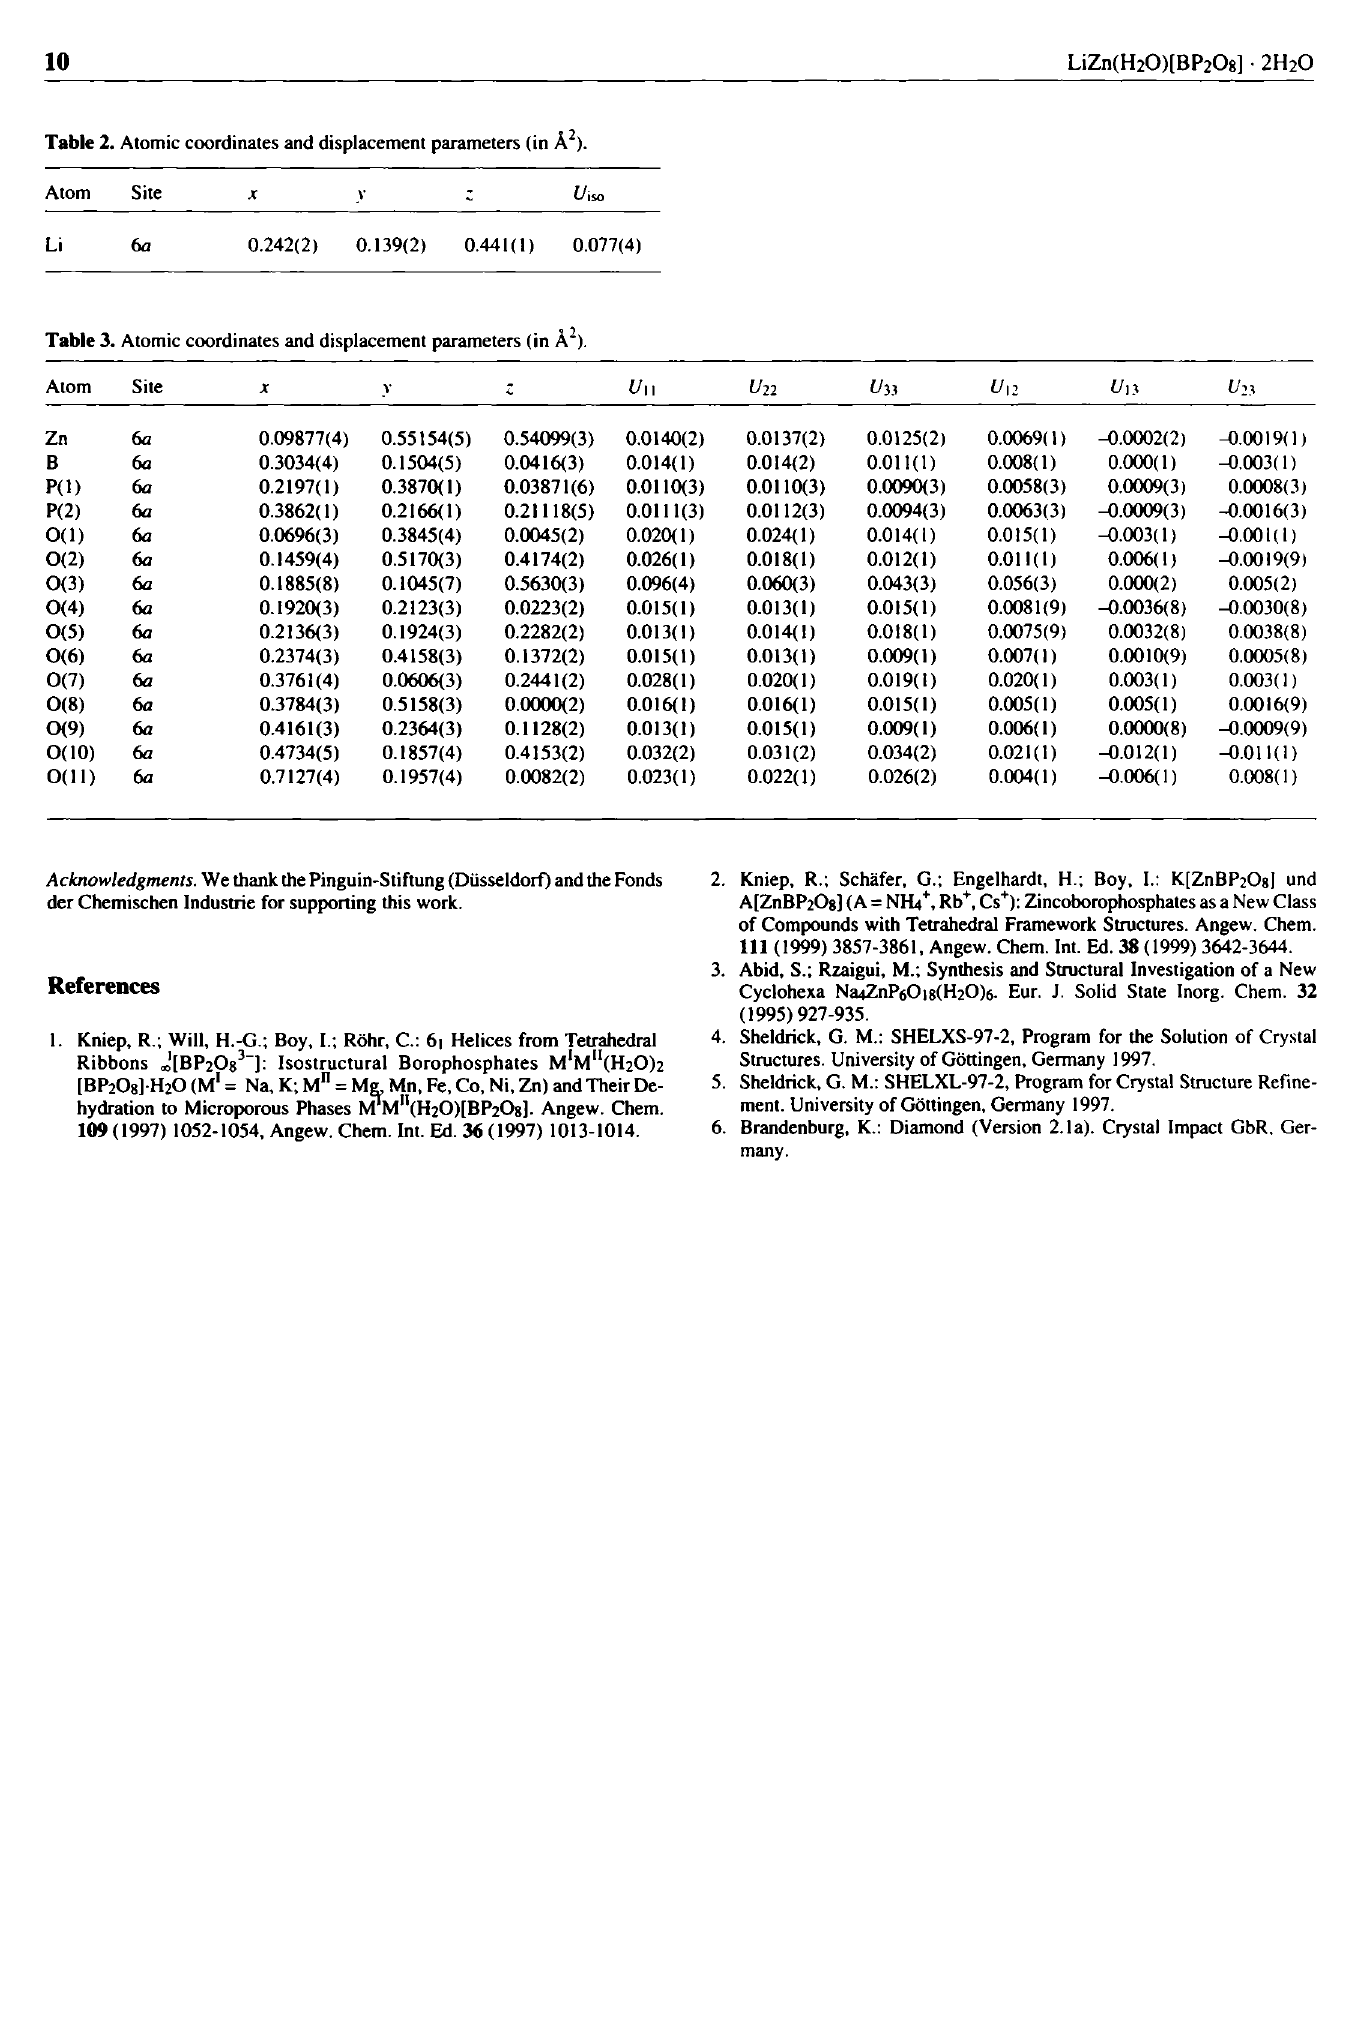
Table 2. Atomic coordinates and displacement parameters (in A 2 ).